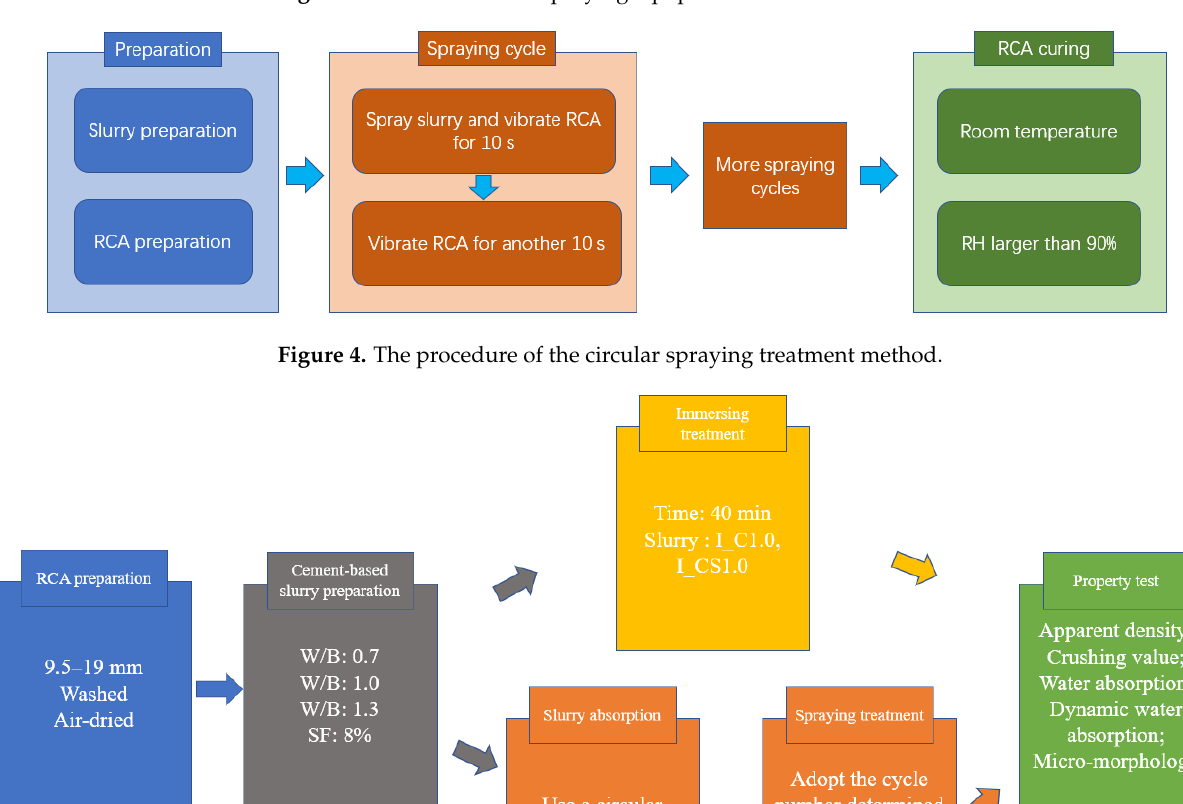
Figure 3. Schematic of the spraying equipment.